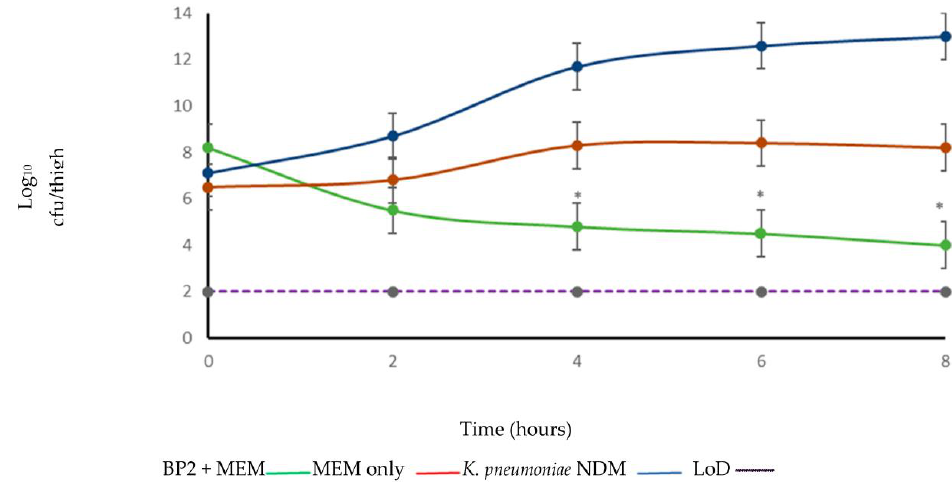
Figure 7 . The efficacy of BP2 combination therapy over monotherapy in a murine thigh infection model. Neutropenic BALB/c mice were infected with 0.1 mL of 10 6 – 10 8 cfu of K. pneumoniae NDM-1 IM (MEM MIC 128 mg/L). Mice were treated via IP with either S, M (100 mg/kg) or BP2 (100 mg/kg) and meropenem (100 mg/kg) two hours post inoculation. Colony counts in PBS were performed from thigh homogenates every two hours. Treatment groups were analyzed using the ANOVA method of comparison, with a p < 0.005 considered statistically significant. The co-administration of BP2 and meropenem resulted in a significant decrease in K. pneumoniae NDM cfu/mL in comparison to S and M treatment. This indicates that BP2 + meropenem is a favourable treatment strategy. MEM = Meropenem, LoD = Limit of Detection. n = 6 mice per time point per group, cfu/mL counts were done in triplicate. * denotes p < 0.005. Figure 7 depicts the outcome of a successful murine infection model. K. pneumoniae NDM colonies were reduced by >3 log 10 units, and the deviation between the doses of BP2 + meropenem administered was <8% (Tables S1 — S3, indicating statistical significance ( p < 0.005).